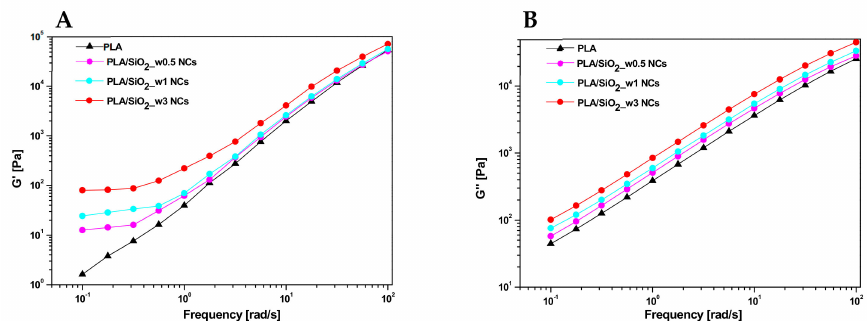
Figure 10. ( A ) Storage modulus and ( B ) loss modulus versus frequency curves at 180 ◦ C for neat PLA and nanocomposites filled with 0.5, 1.0 and 3.0 wt% of wrinkled SiO 2 nanoparticles.